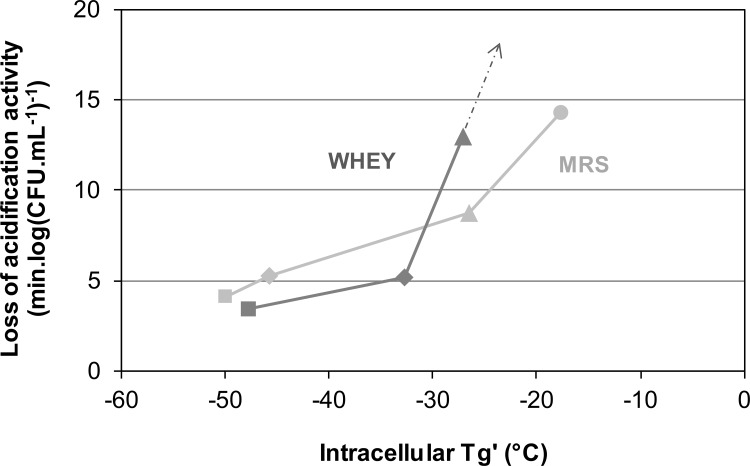
The loss of specific acidification activity on thawing of L. bulgaricus plotted against intracellular vitrification temperature (Tg’).Cells were grown in either whey (dark grey) or MRS medium (light grey), harvested in stationary culture phase and frozen to -80°C at 2°C min-1 with sucrose (triangles), glycerol (diamonds) or DMSO (squares), (all additives at 0.58 M) and MRS control (circle). Dotted arrow indicates the direction of control whey grown cells loss in cell function (64.8 ± 3.5 (min.log(CFU mL-1)-1)).